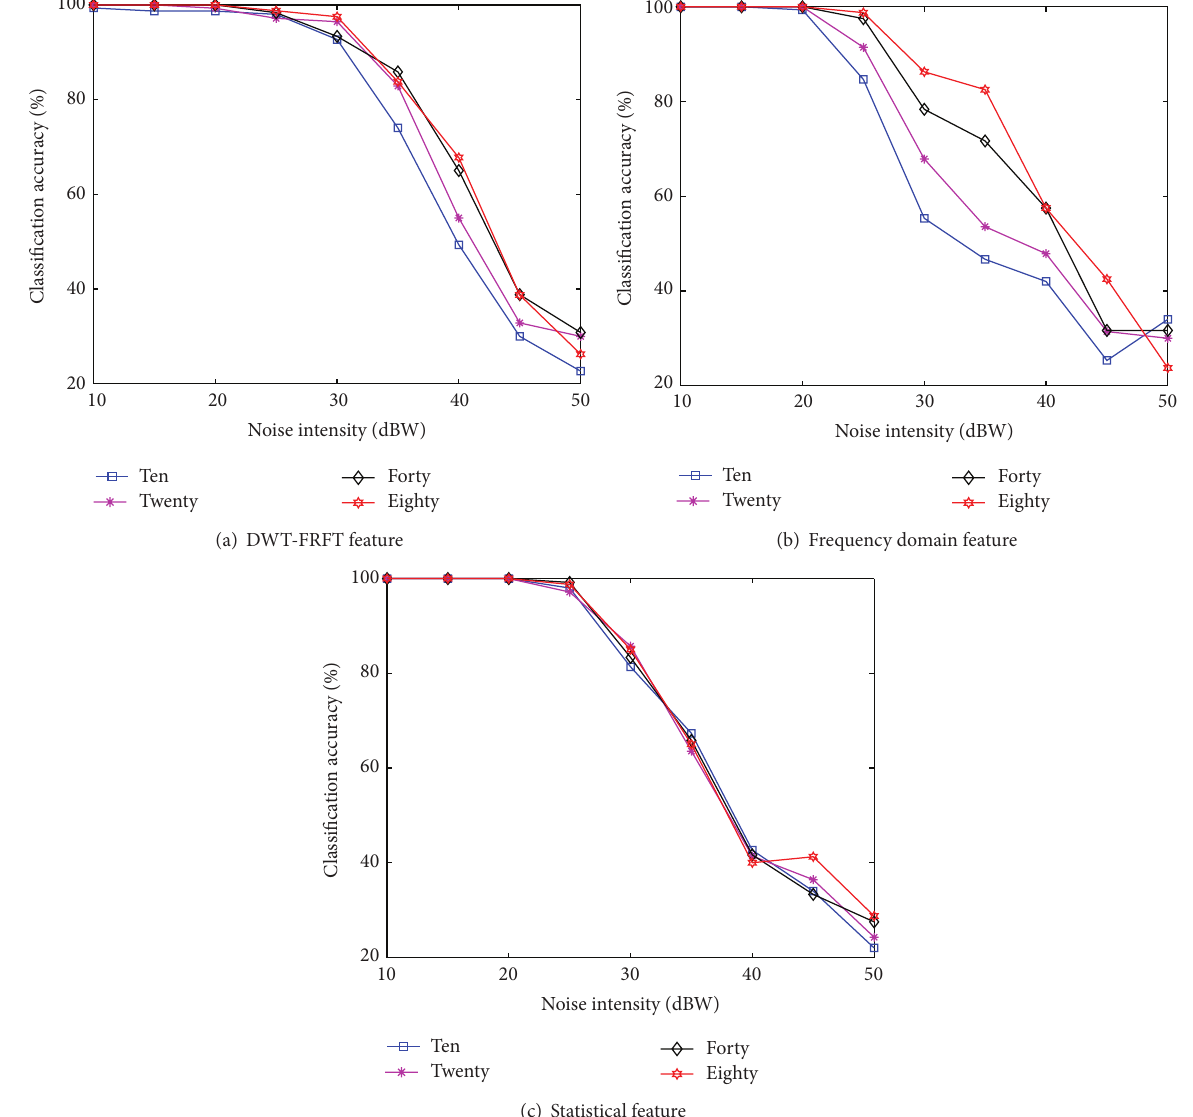
Figure 10: The influence of SVM mode.